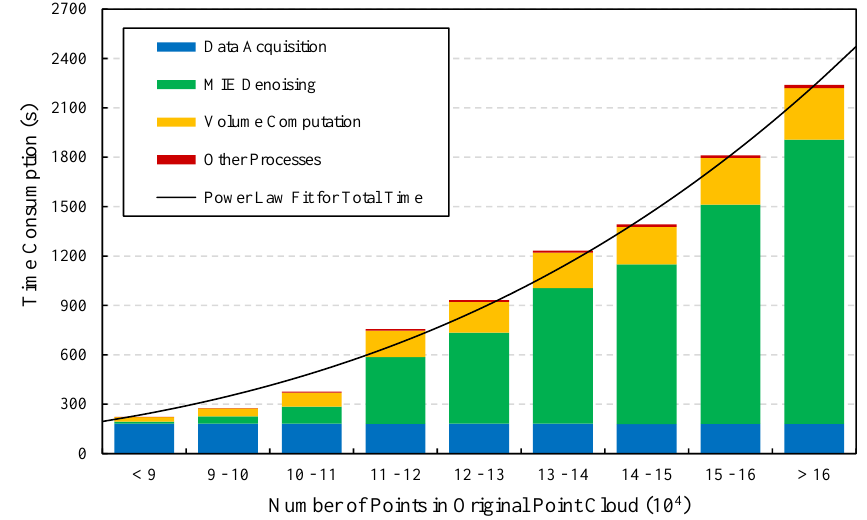
Figure 15. Time consumption of our system, for single plant measurement. The data are grouped by the number of points in original point clouds and the major time-consuming processes are in different colors.